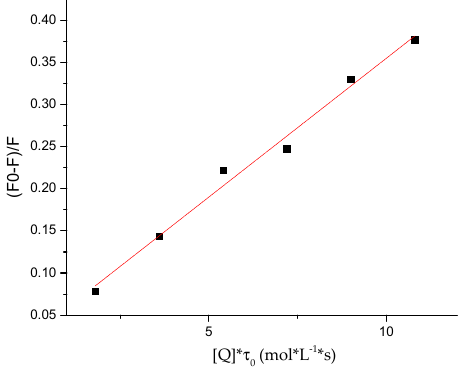
Figure 3. Fluorescence spectra of bovine serum albumin (BSA) (1.5 µ M; λ max = 341 nm) in the presence of compound 7e (0.3 µ M; 0.6 µ M; 0.9 µ M; 1.2 µ M; 1.5 µ M 1.8 µ M; λ max = 339 nm).